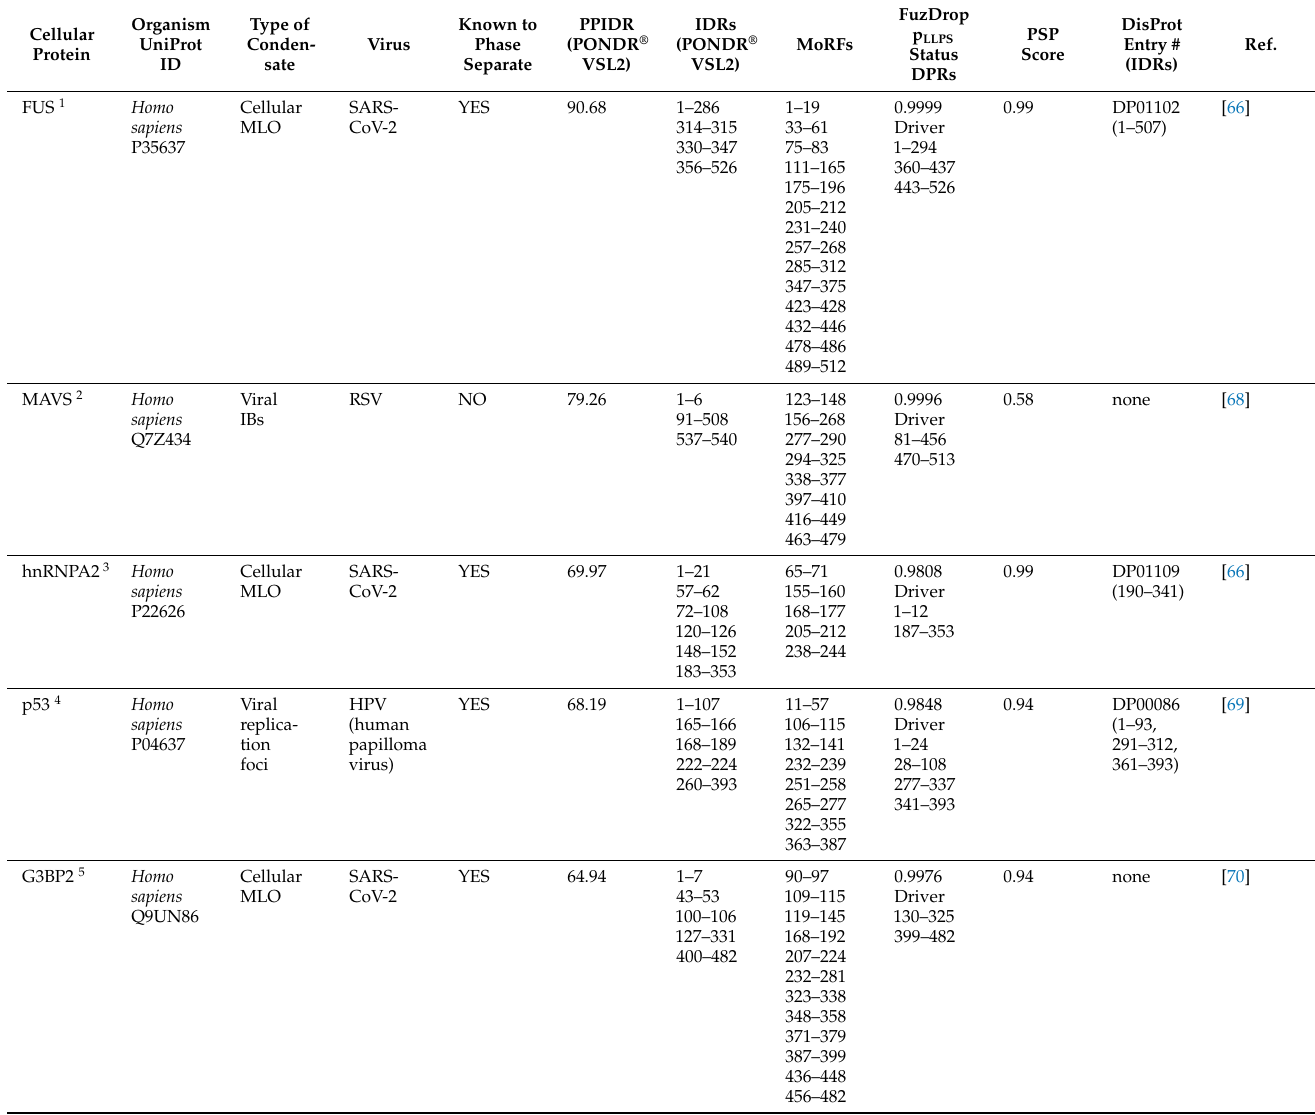
Table 1. Eukaryotic proteins recruited to MLOs related to viral